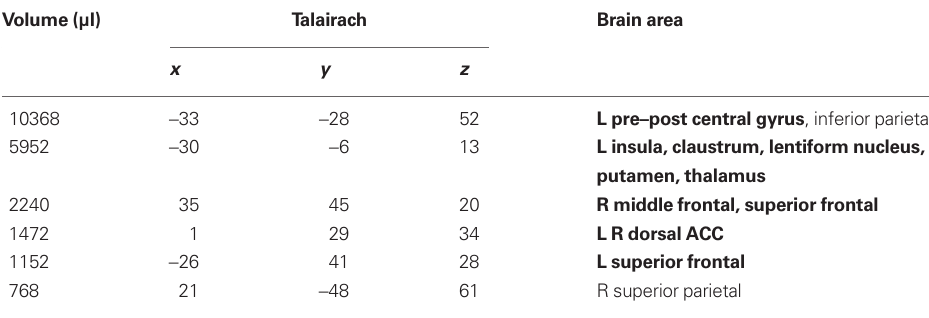
Regions that are also active in the contrast receding > standard disc are highlighted in